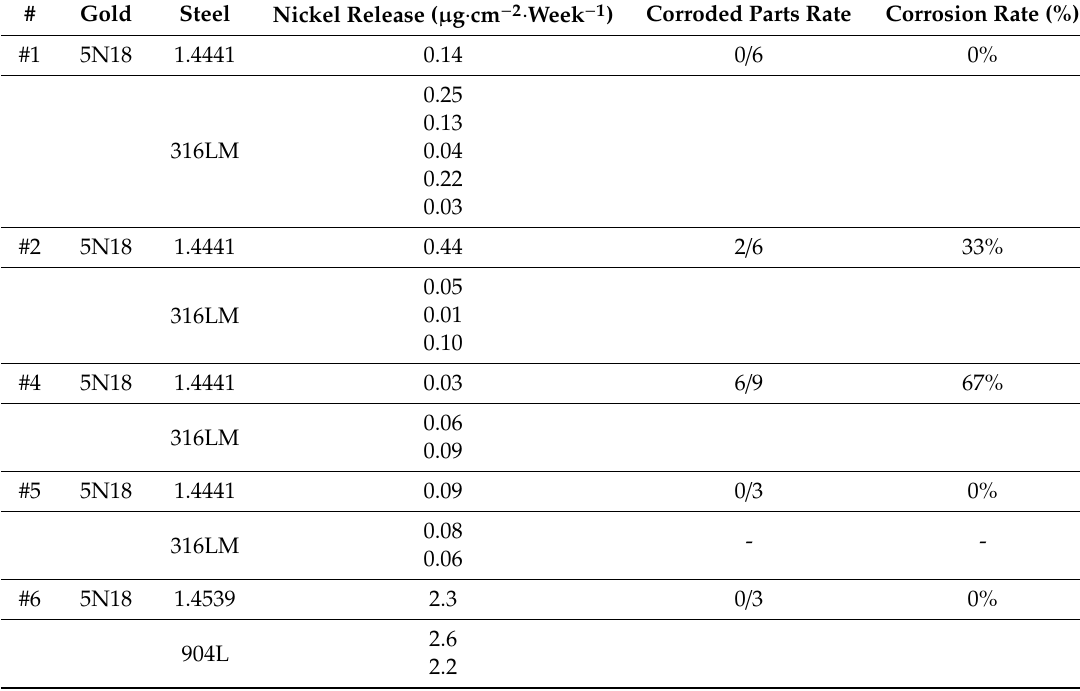
Table 12. Tests results for gold-stainless steel links.